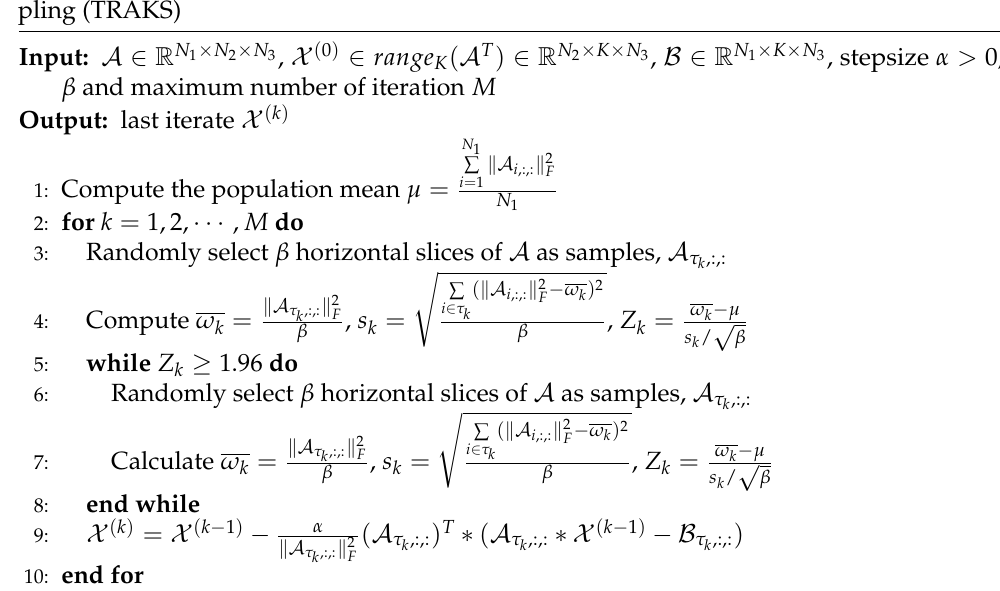
Algorithm 5 Tensor randomized average Kaczmarz algorithm with random sam- pling